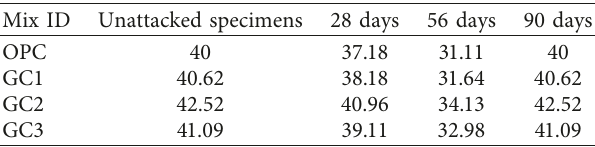
Table 7: Compressive strength values of the geopolymer and OPC concrete mixes after sulphate test for different curing